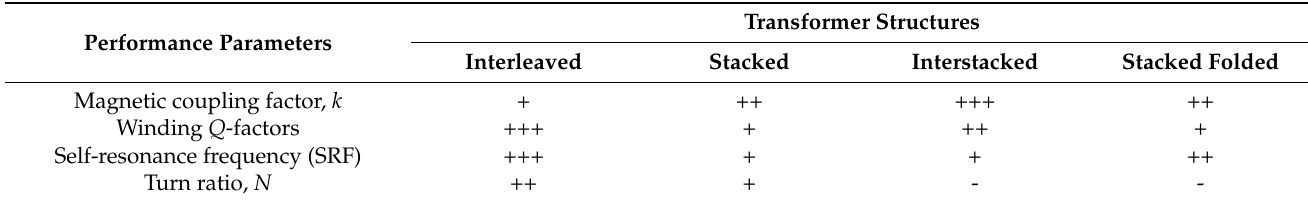
Table 2. Pros and cons of different integrated transformer